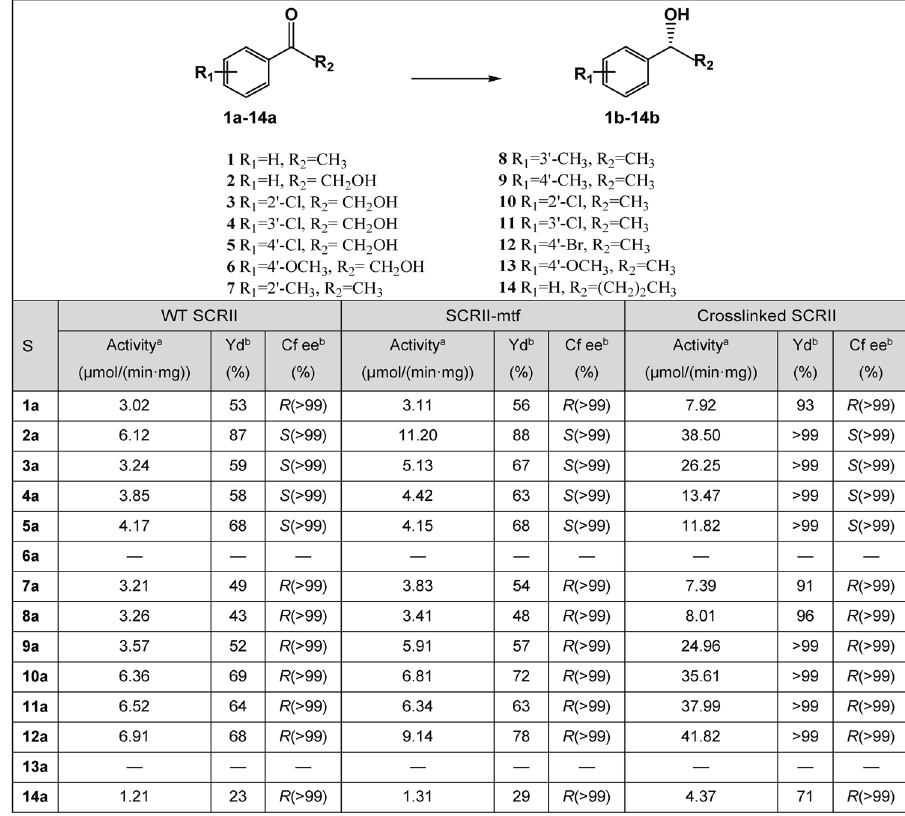
Figure 5. Substrate specificities of WT SCRII, SCRII-mtf and SrtA-mediated Crosslinked SCRII. a Standard